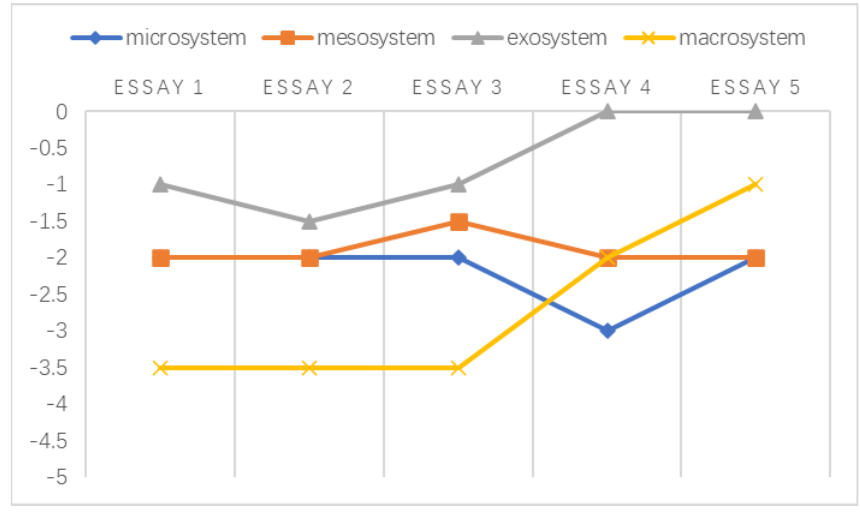
Figure 4. An illustration of T3’s emotional changes in the ecological systems after grading five essays.